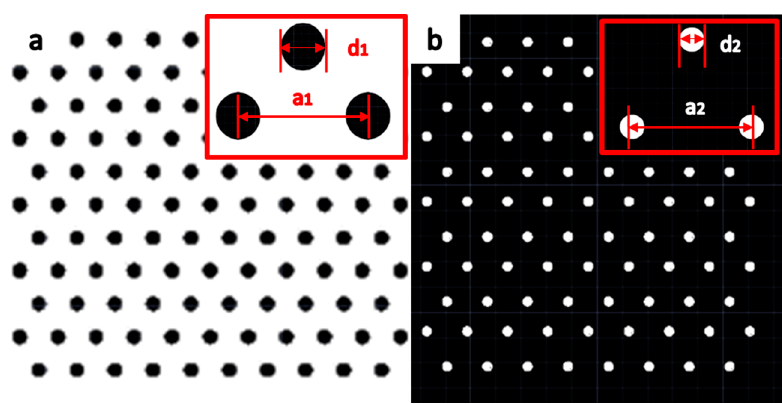
Figure 2. The schematic diagram of the mask size parameter of the two samples. ( a ) Array tips sample mask. ( b ) Array pits sample mask.